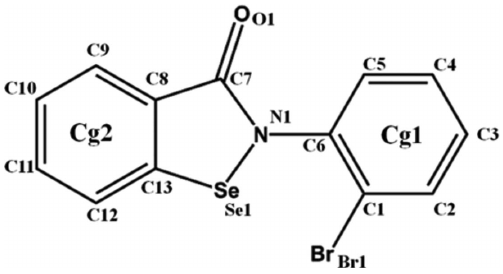
Figure 2 The chemical structure of 2-(2-bromophenyl)benzol[ d ][1,2]selenazol- 3(2 H )-one, (cid:4) -Se, showing the atom- and ring-numbering